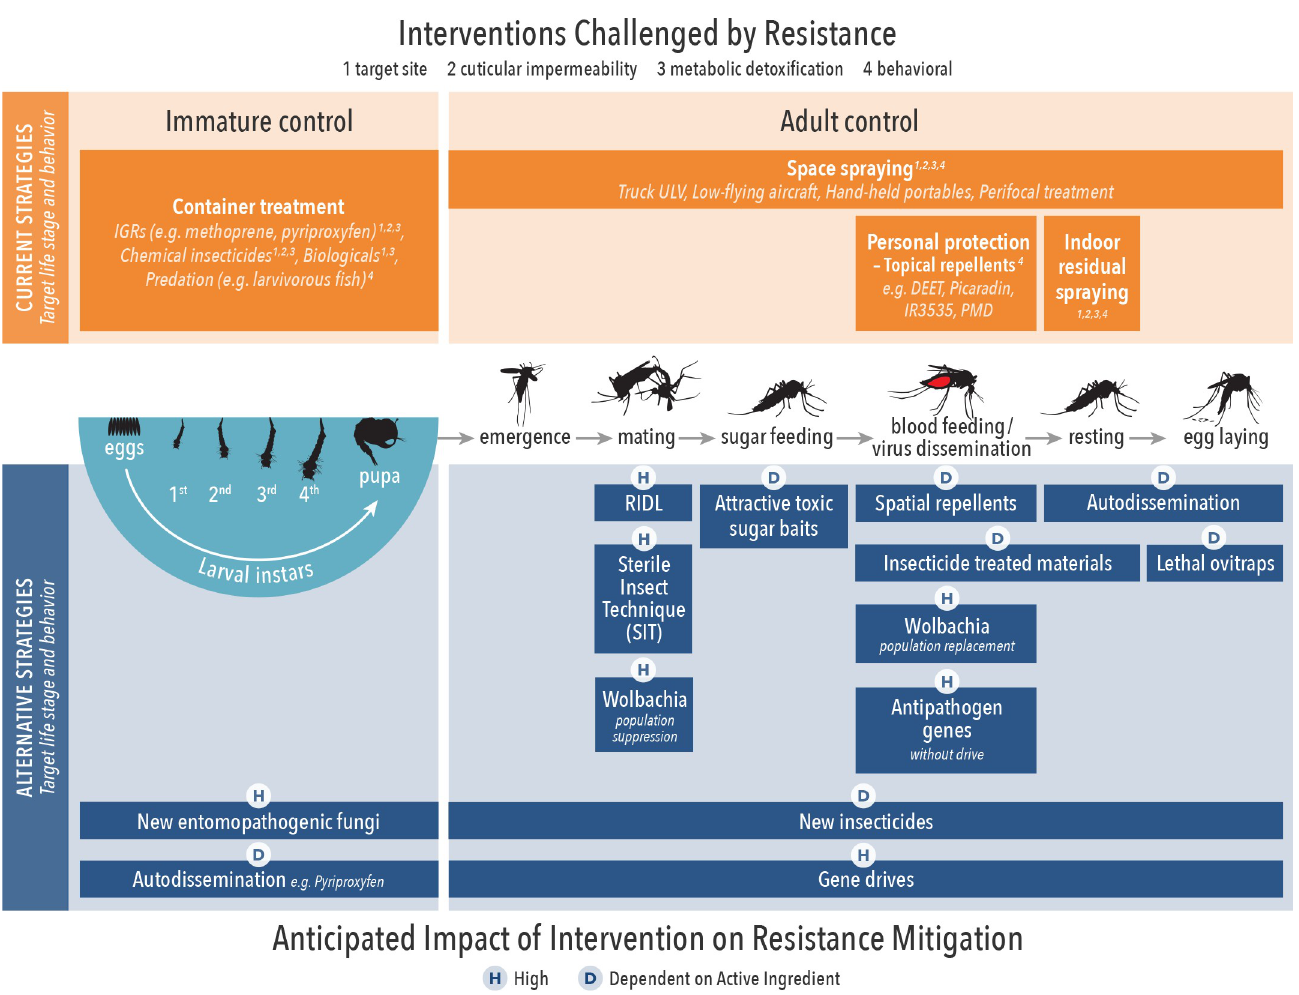
Fig 2. Principle of a gene drive. (A) Initial integration of a gene drive construct into the mosquito genome: Cas9 and the gRNAs encoded in the transgenic construct prepared as a plasmid can serve as molecular scissors mediating their own integration into the genomic target site they cut. Asterisks represent the cut sites determined by the gRNAs (three gRNAs in this example). Homologous recombination-mediated knock-in of the transgenic cassette occurs thanks to the target site flanking sequences cloned into the plasmid. (B) Spread of the gene drive in a mosquito population: mating between transgenic and nontransgenic mosquitoes places the transgenic construct in the presence of wild-type chromosomes that get cut by Cas9 at the target site determined by the gRNA(s). This break is repaired most frequently by homologous recombination with the intact chromosome, effectively copying the trans -gene into the broken wild-type chromosome and converting a heterozygous into homozygous cell. Cas9, CRISPR associated protein 9; gRNA, guide